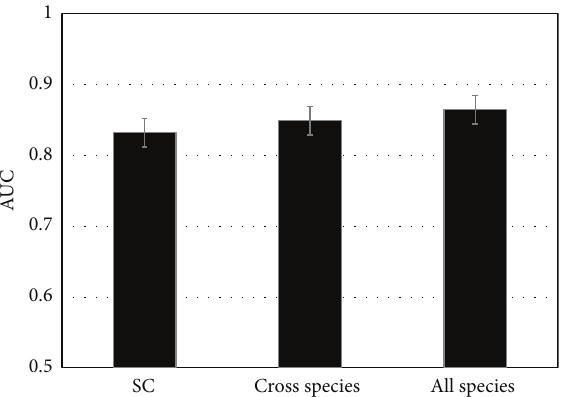
Figure 4: Comparison of PPI prediction accuracy in the GO2PPI + Phyloprof category. Error bars show standard